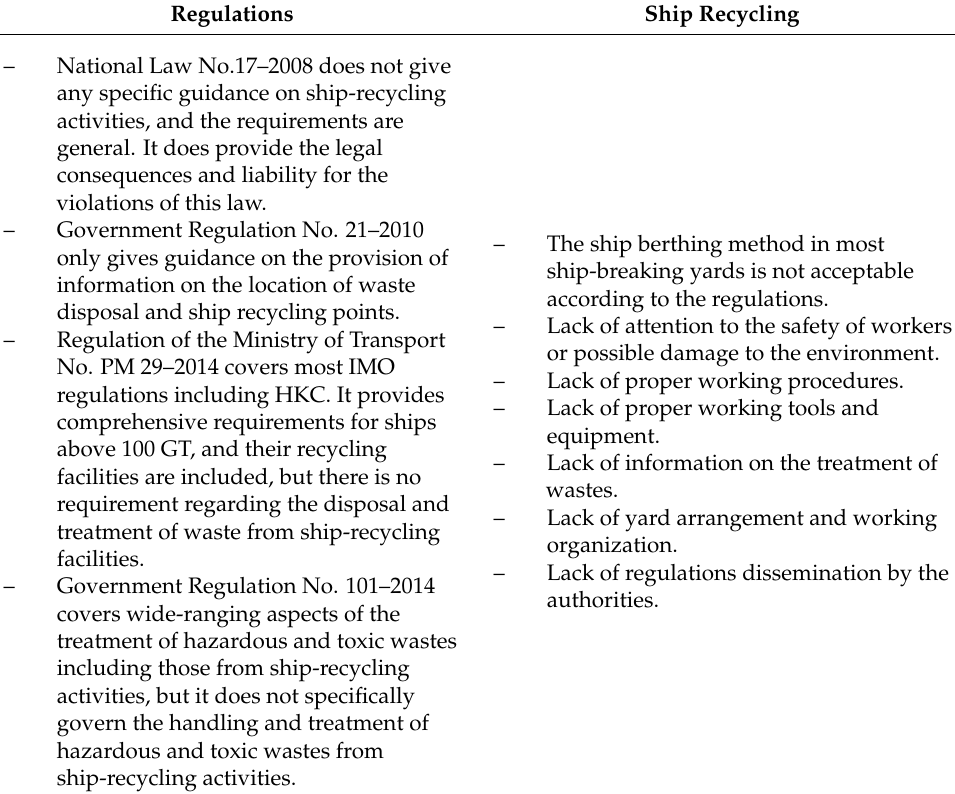
Table 3. Results of the gap